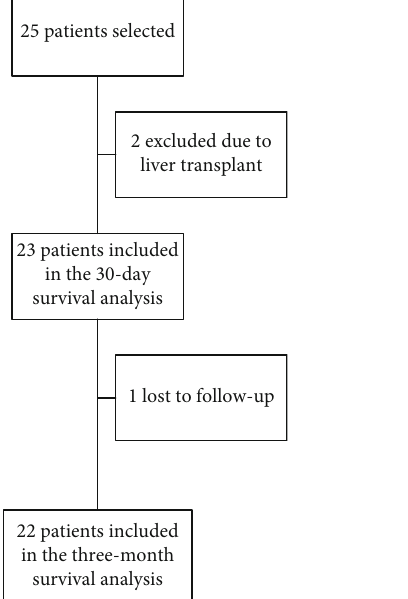
Figure 1: Sample, exclusions, losses, and fi nal number of participants.